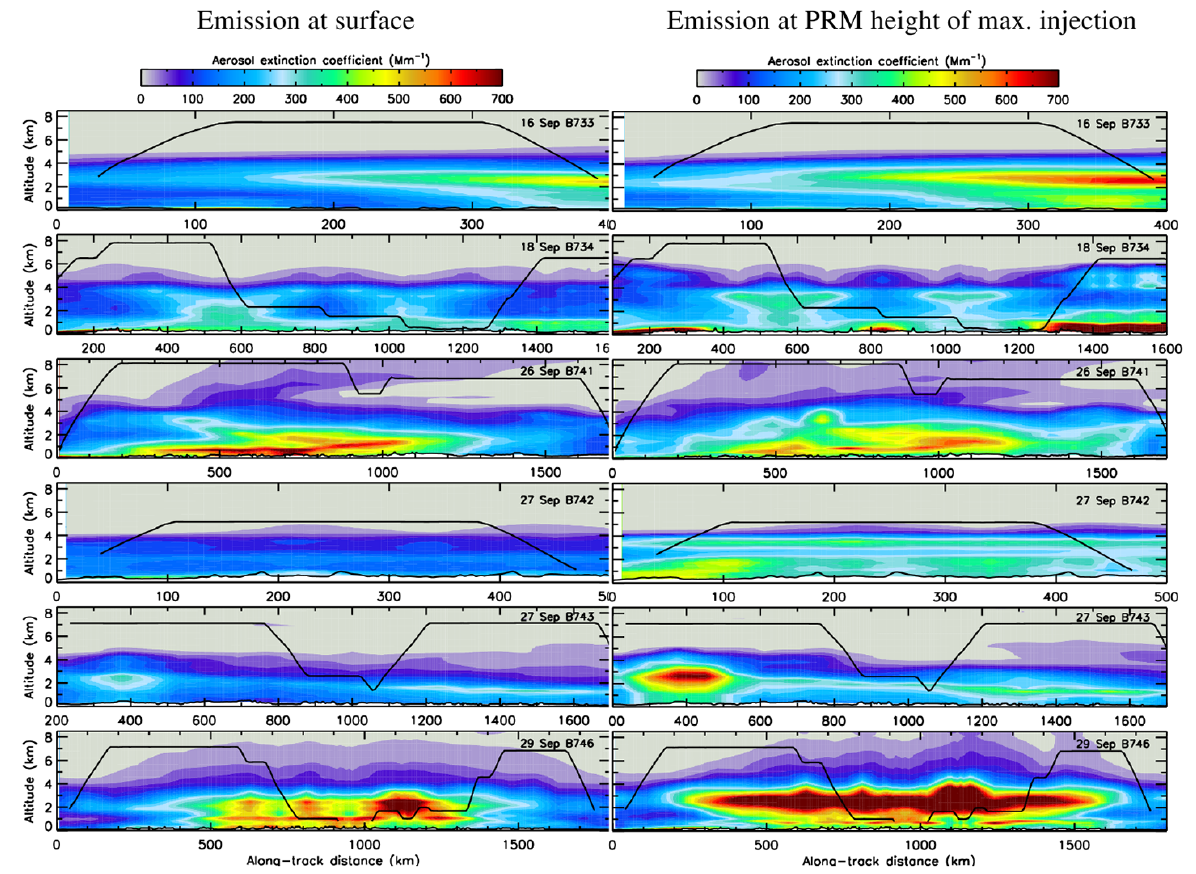
Figure 11. Cross sections of the aerosol extinction coefficient at 532nm estimated from the C-IFS along the tracks of the six research flights. Biomass burning aerosols are emitted at the surface (left) and at the PRM mean height of maximum injection provided by GFAS (right).